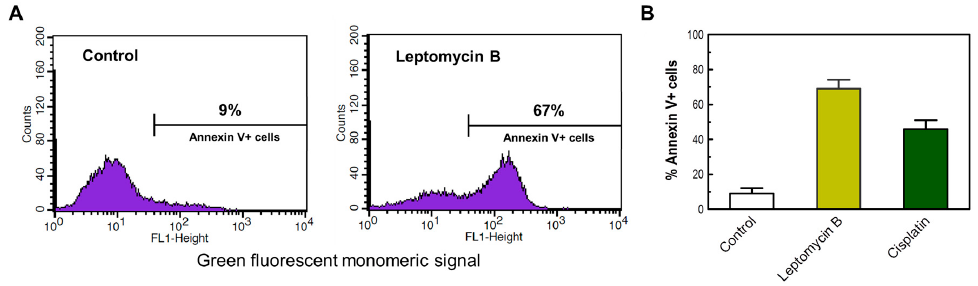
Figure 8. ( A ) Representative flow cytometry profiles of HCT116 cells assessed for Annexin V positivity after incubation in the absence (control) or presence of leptomycin B (2 μ M) for 3 days. ( B ) The percentages of Annexin V-positive cells in HCT116 cultures incubated in the absence or presence of leptomycin B (2 μ M) or cisplatin (60 μ M) for 3 days. Bars, SE.